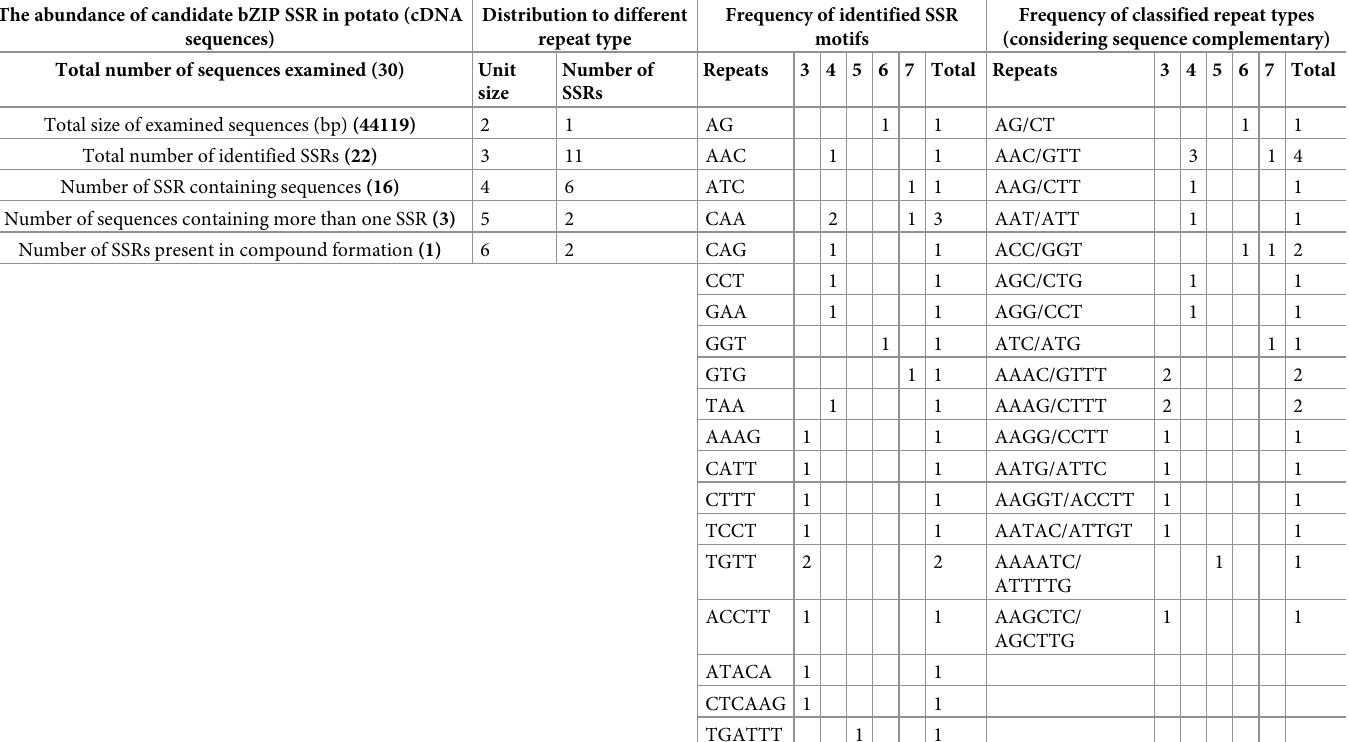
Table 2. Mining of SSRs from candidate StbZIP